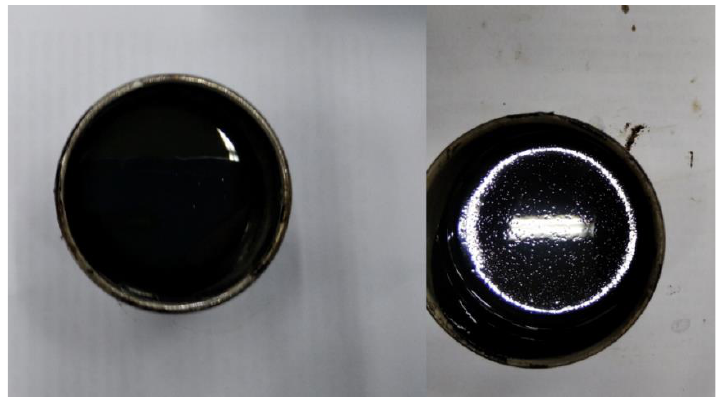
Figure 9. Penetration test samples of RB ( left ) and LP-15 ( right ) .